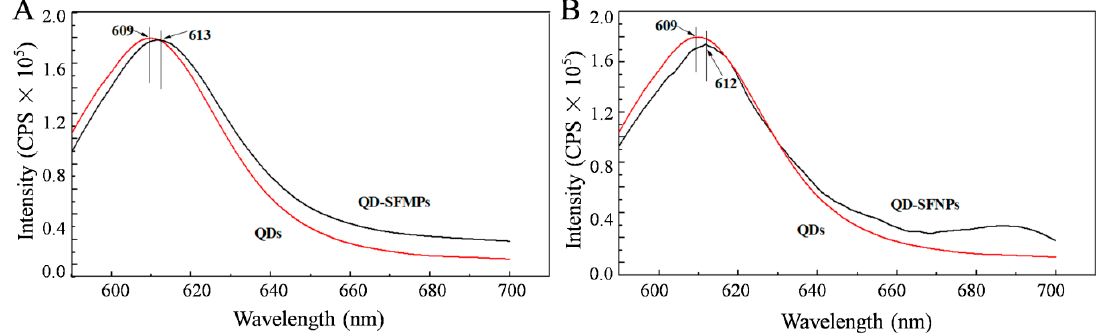
Figure 5. Fluorescence spectra of QDs, QD-SFMPs and QD-SFNPs. ( A ) QDs and QD-SFMPs; ( B ) QDs and QD-SFNPs. Excitation: 550 nm, Emission: 590–700 nm.